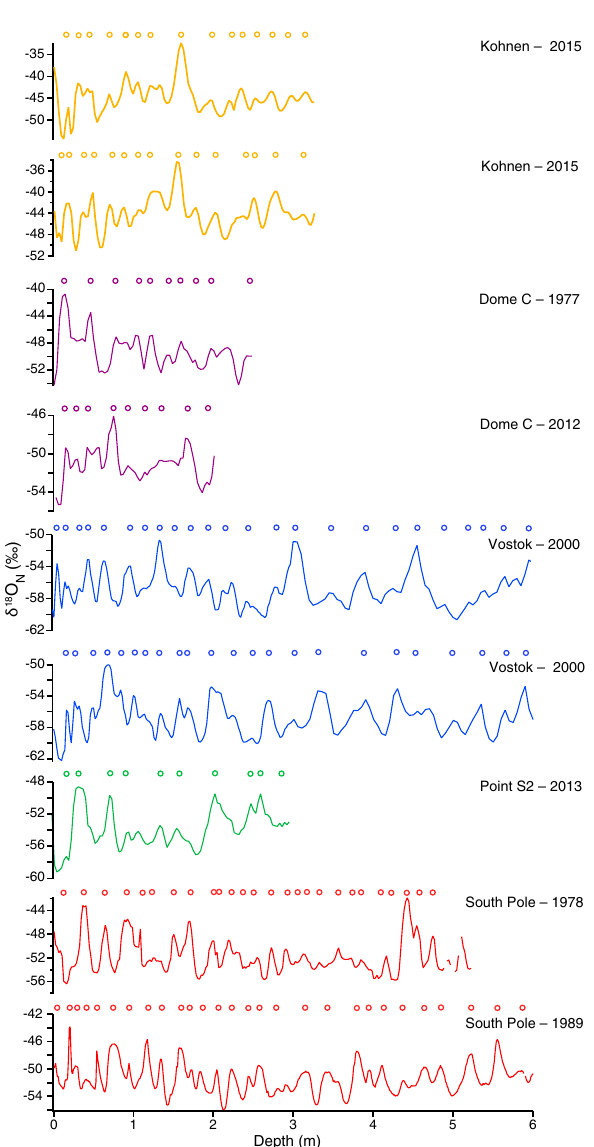
Figure B1. Isotopic composition profiles from pits δ 18 O N at Kohnen (yellow), Dome C (purple), Vostok (blue), S2 (green) and South Pole (red). The circles indicate the counting of cycles for each profile using a minimal amplitude difference of